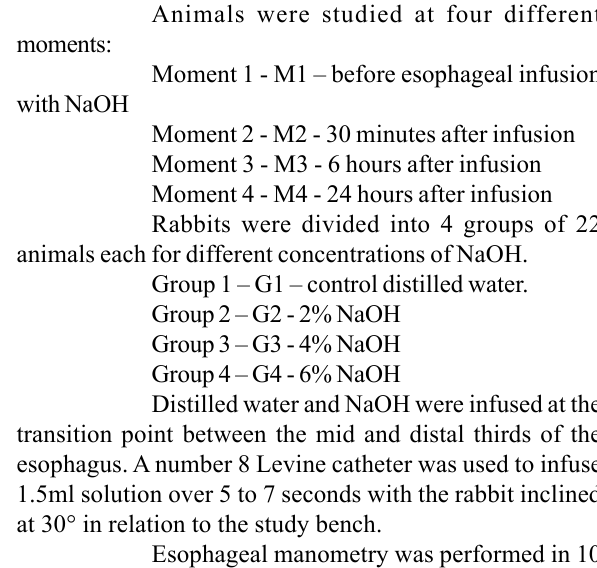
FIGURE 1 - Lesions provoked by esophageal infusion of NaOH (4%): ulcers and ecdysis of